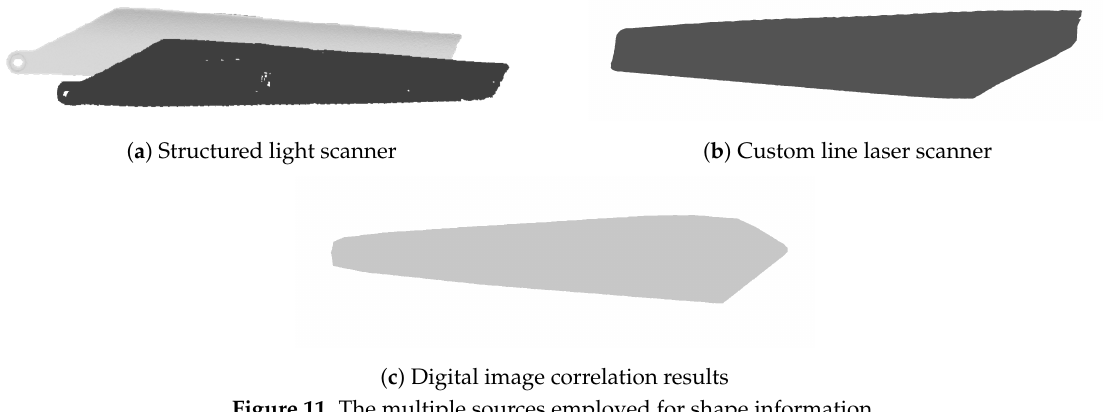
Figure 11. The multiple sources employed for shape information.